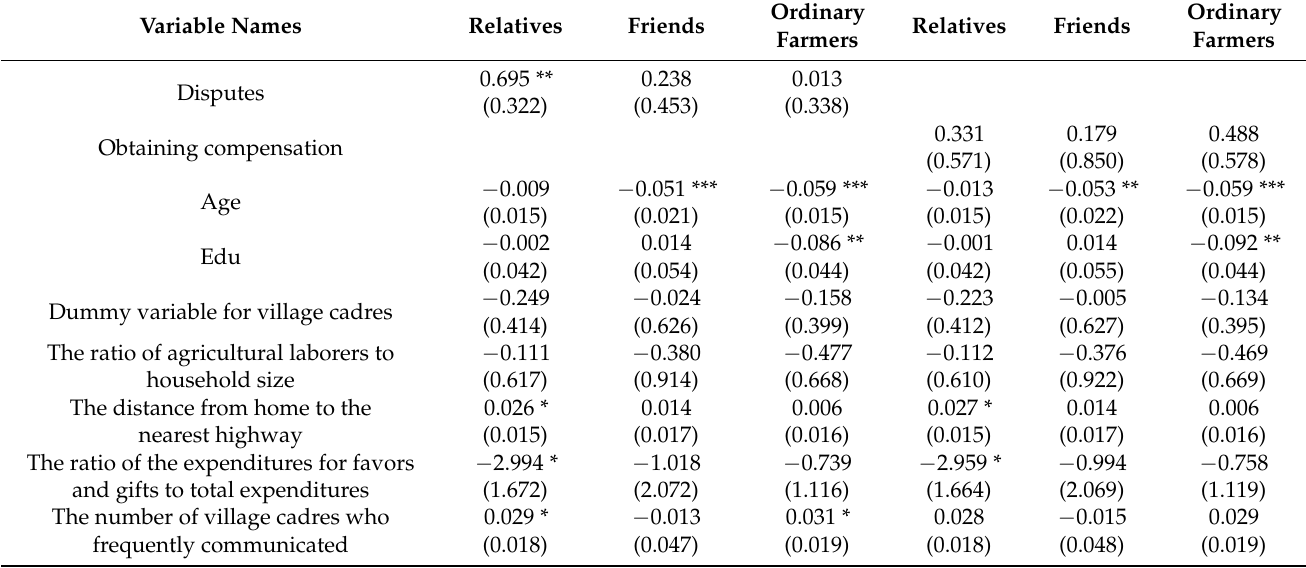
Table 6. Estimation results of mlogit